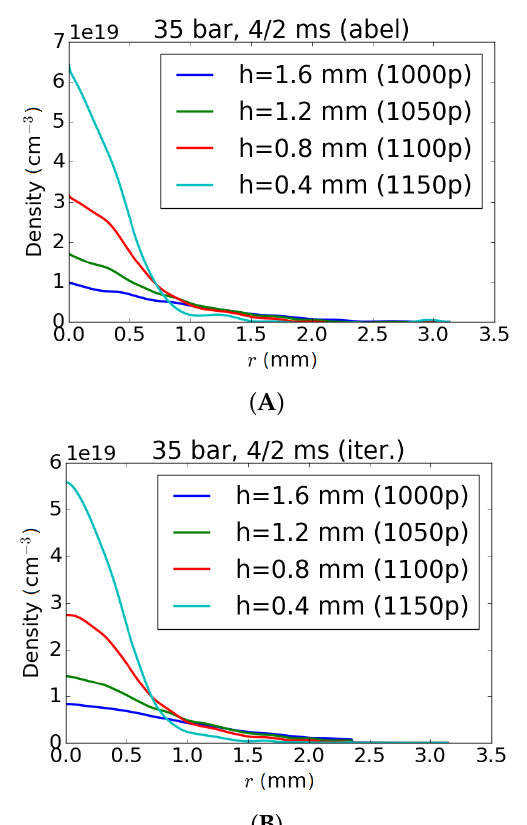
Figure 8. Test of ML-EM on the undisturbed (rotationally symmetric) gas distribution. The distance from the nozzle is given in mm; the corresponding pixel row is placed in brackets. In general, good agreement is found between the Abel inversion ( A ) and ML-EM after 15 iterations ( B